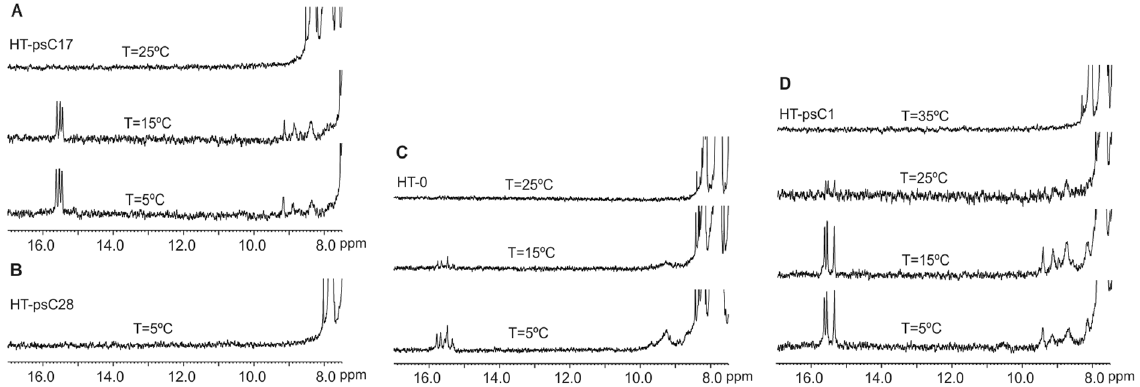
Figure 5. Single psC residue at position 1 in HT sequence stabilizes i-motif structure at neutral pH. Series of NMR spectra at different temperature of: ( A ) HT-psC17 , ( B ) HT-psC28 , ( C ) HT-0 and ( D ) HT-psC1 . [oligonucleotide] = 100 μ M, 10 mM phosphate buffer, pH